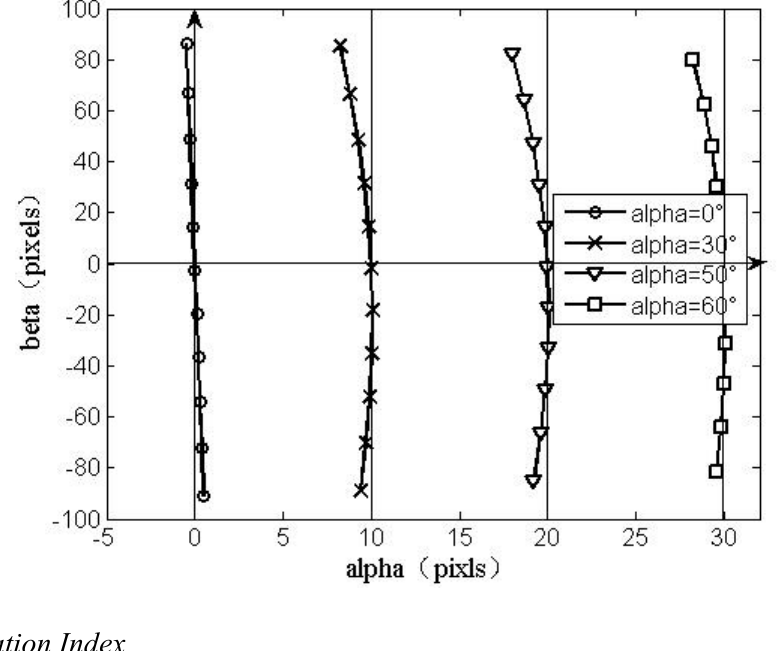
Figure 10. The coordinate shift trend of HASS before